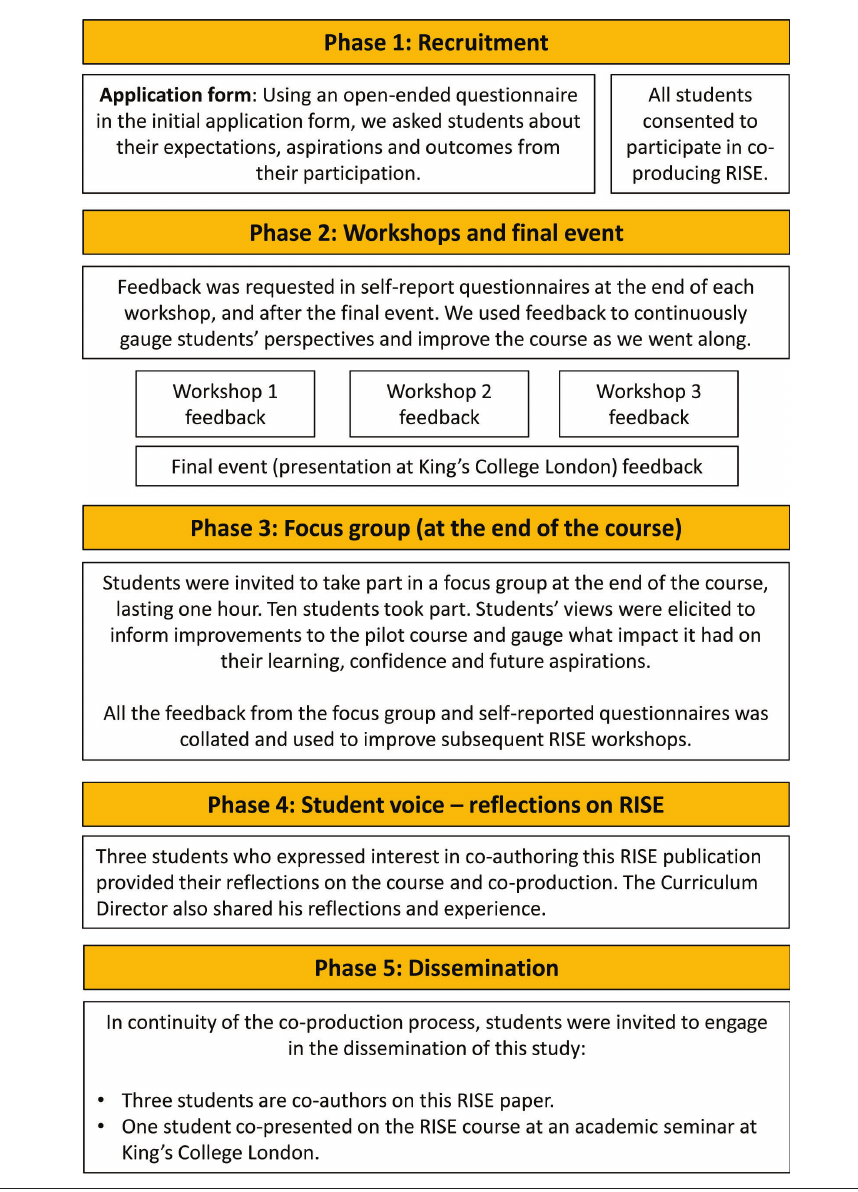
Figure 2: Co-production phases of the RISE